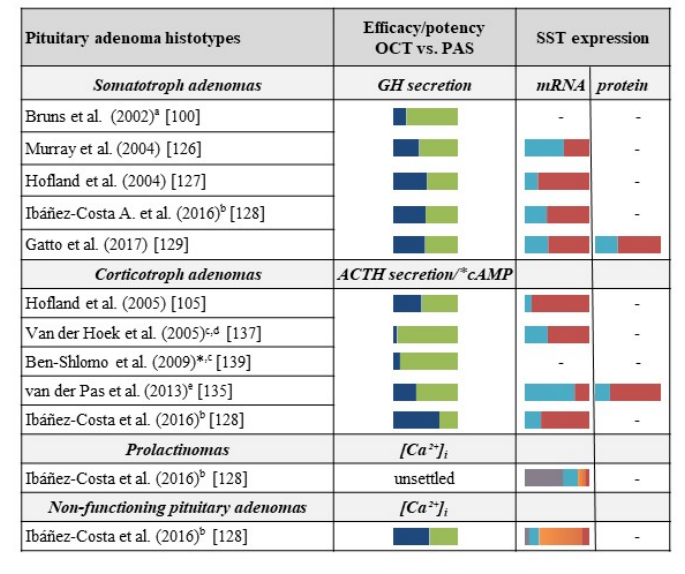
Figure 3. Di ff erential e ff ects of OCT and PAS on pituitary adenomas, in relationship with the SST profile. In the left column, blue = OCT and green = PAS. In the right column, light blue = SST2, red = SST5, grey = SST1, and orange = SST3. cAMP, intracellular cAMP level. [Ca 2 + ]i, intracellularcalciumconcentration. a GH release by primary cultures of rat anterior pituitary cells, after 6 h of treatment. b Data extracted from graphs presented in the related article. c Study carried out using the AtT20 cell line. d E ff ect of OCT and PAS on CRH-induced ACTH release after pre-treatment with DEX and mRNA expression after 24 − 48 h of DEX. e Primary cultures from patients with normalized urinary-free cortisol. * Studies in which changes in cAMP accumulation in response to OCT or PAS was analyzed.